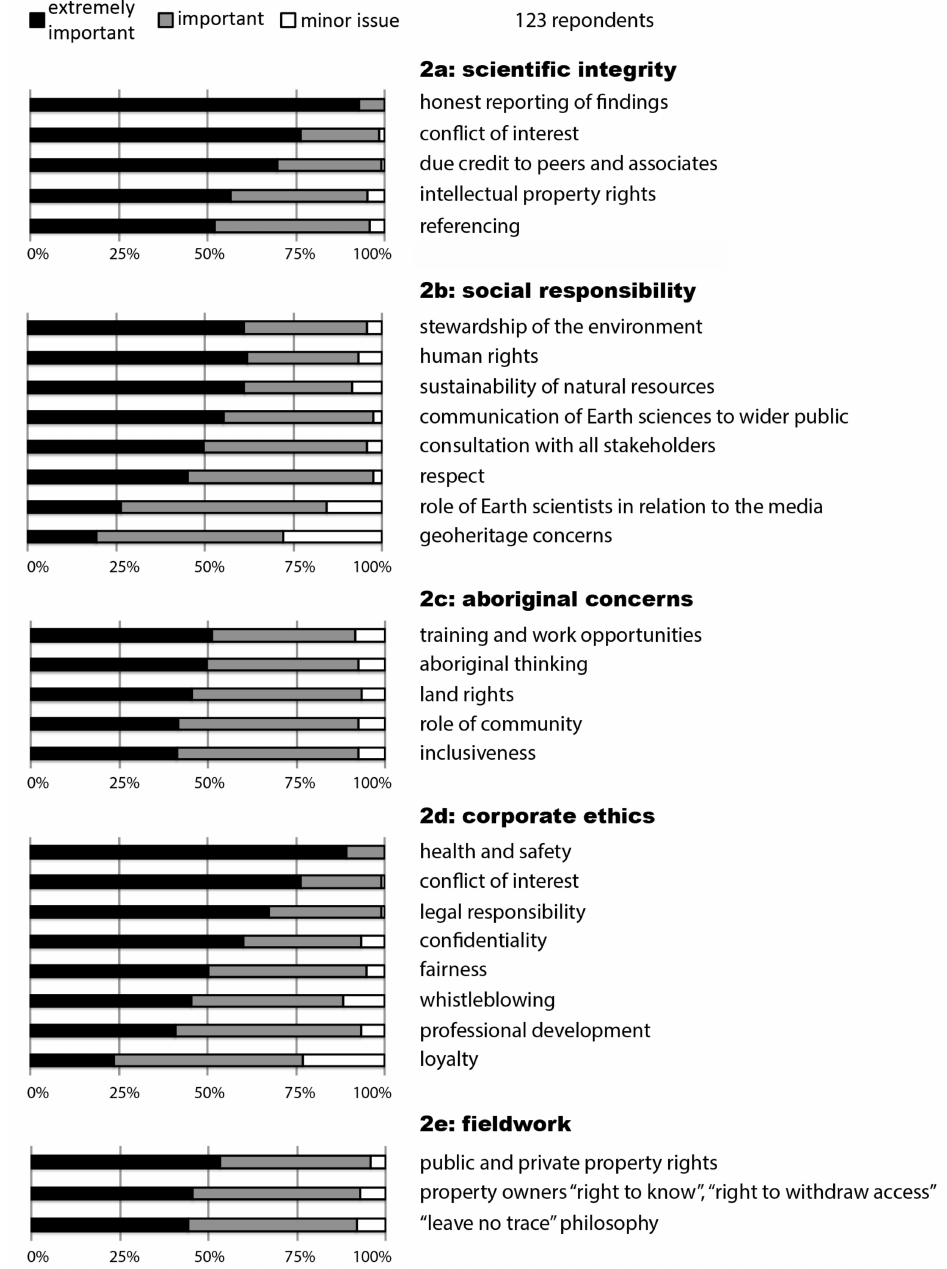
Figure 2. Survey results divided by category. Results within each category are sorted by decreasing importance, not in the order they were presented in the